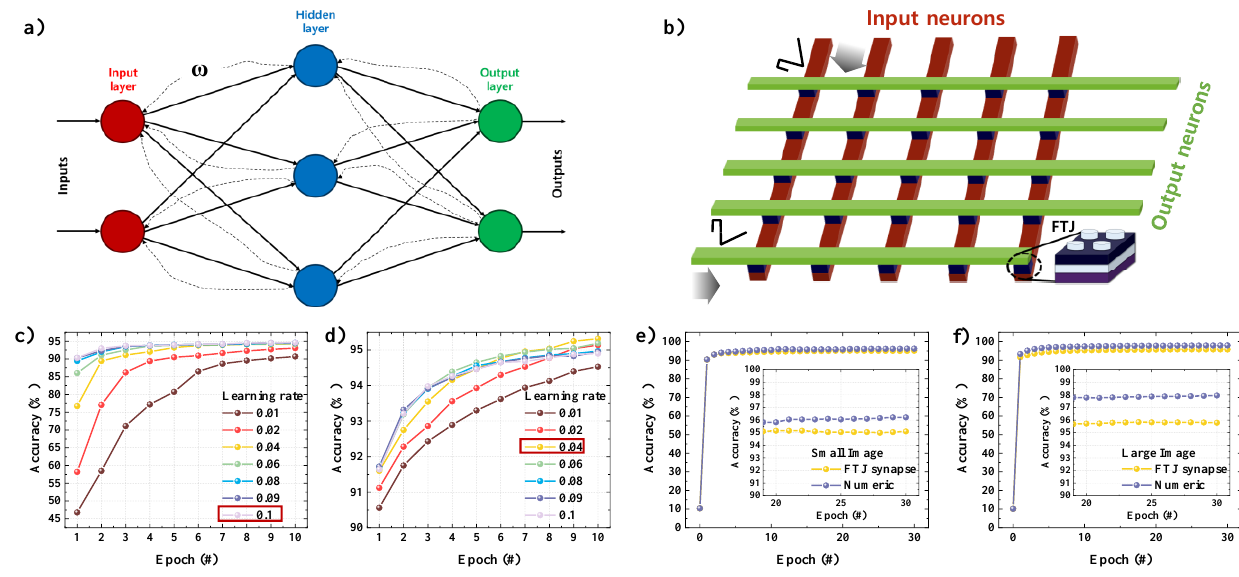
Figure 6. Artificial neural network simulation based on the LTP and LTD data extracted from the HZO FTJ device. ( a ) Schematic representation of artificial neural network used for the recognition of handwritten digit images used in the simulation. ( b ) Schematic representation of the neural core of the crossbar structure used in the simulation. Pattern recognition accuracy for small-image test datasets ( c ), large-image dataset ( d ) as a function of learning rate. Pattern recognition accuracy of the HZO FTJ device for the small-image test datasets ( e ) and large-image test datasets ( f ).